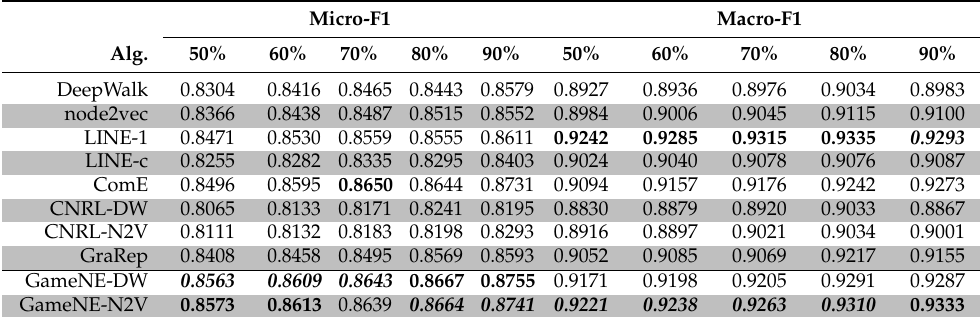
Table 3. Micro- and Macro-F1 Scores of Multi-Label Classification, Network om =